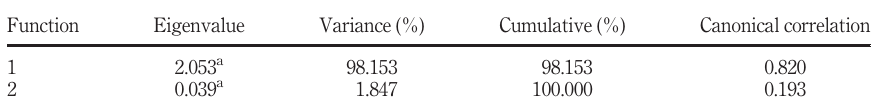
Table 5. Discriminant functions